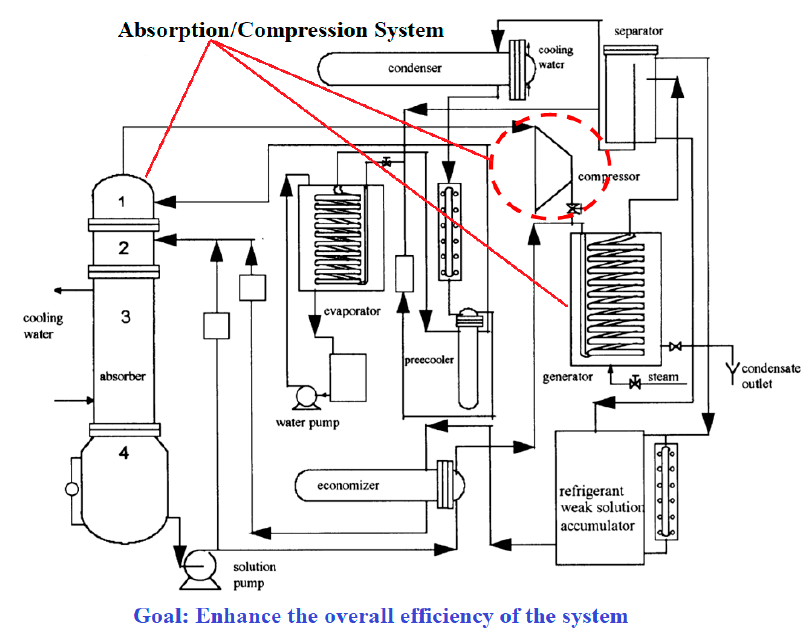
Figure 5. Absorption/compression refrigeration hybrid cycle. Adapted from Ayala and Heard [73] (Reprinted with permission from Elsevier) .